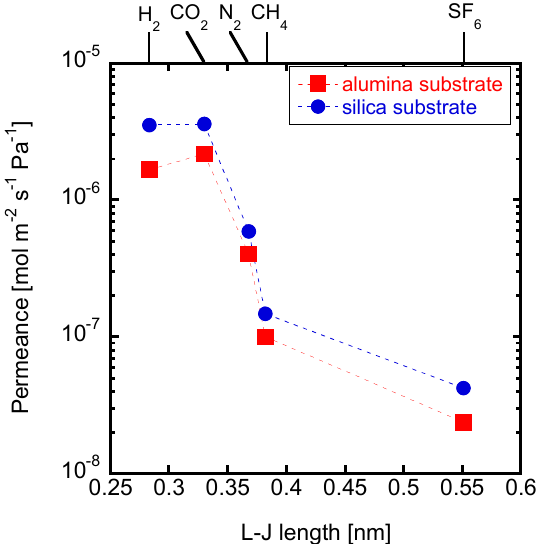
Figure 7. Single gas permeances through the membranes crystallized on different types of substrates (1 SiO 2 :0.8 TMAdaOH:0.8 HF:4.6 H 2 O, 0.01 wt% CHA seeds, 16 h at 423 K).